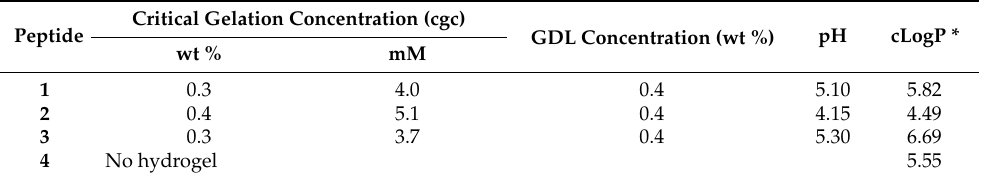
Table 1. Gelation conditions for peptides 1 – 4